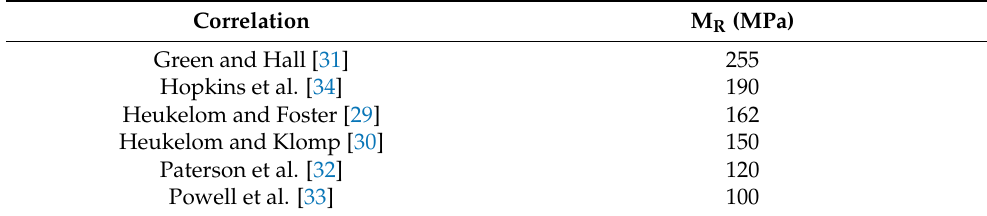
Table 5. Obtained M R values in descending order (CBR =